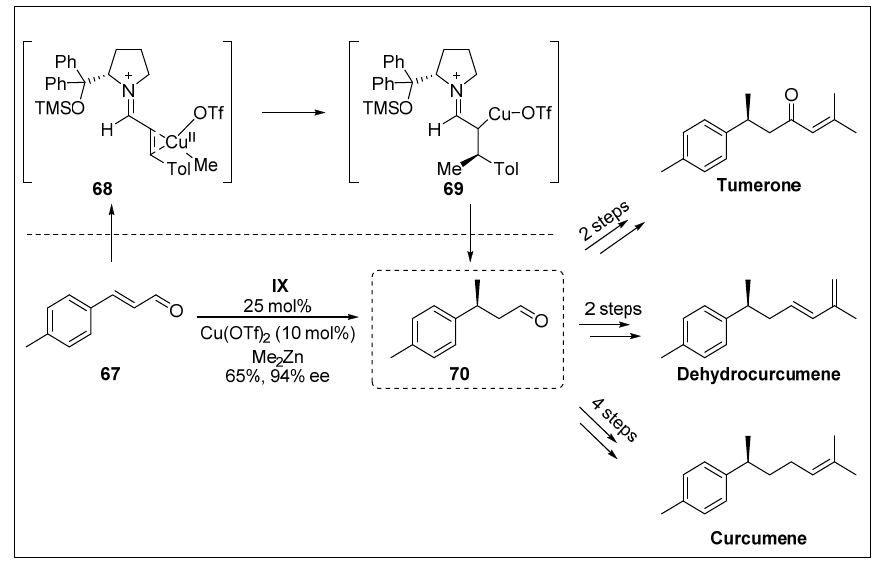
Scheme 21. Total synthesis of (+)-dehydrocurcumene, (+)-tumerone, and